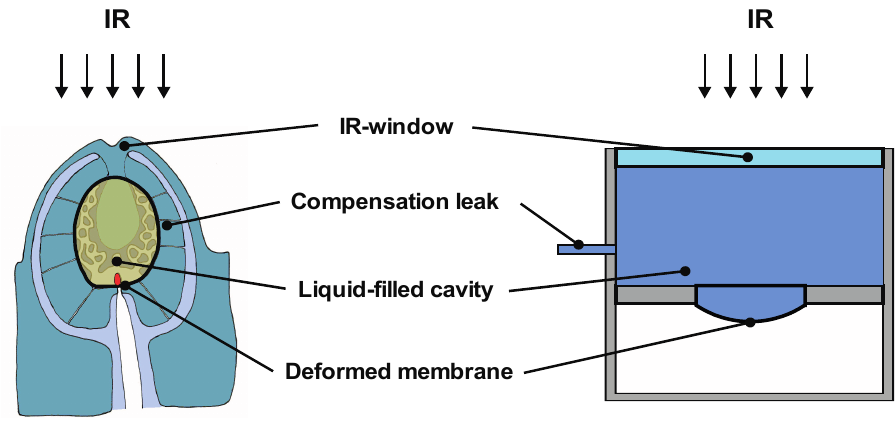
Figure 6. Comparison of the sensillum ( left ) with the model of the sensor ( right